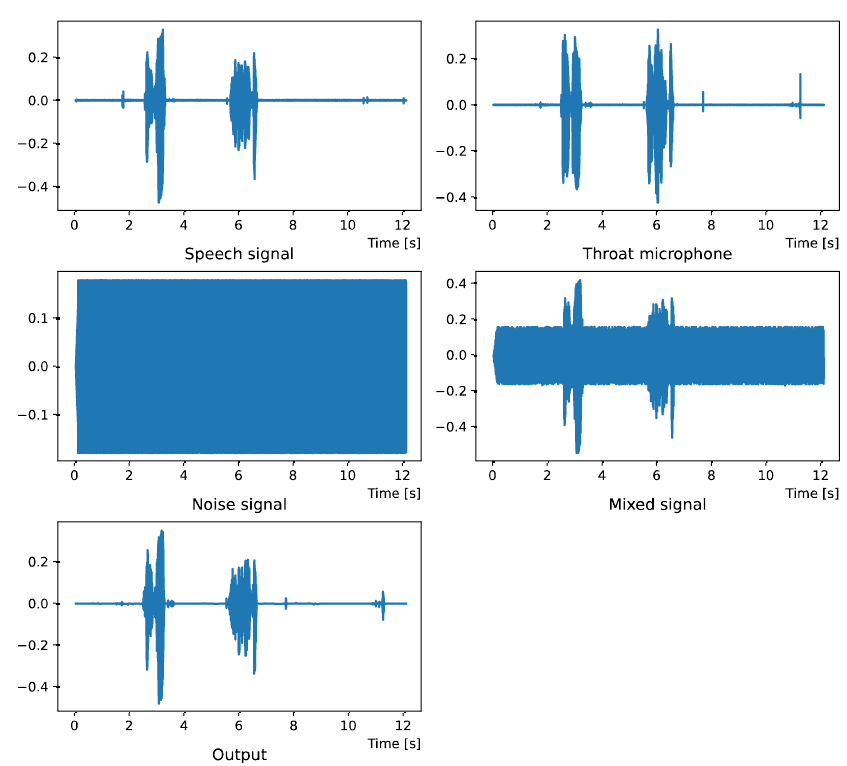
Figure 6. Waveform (White noise (−15 dB)).